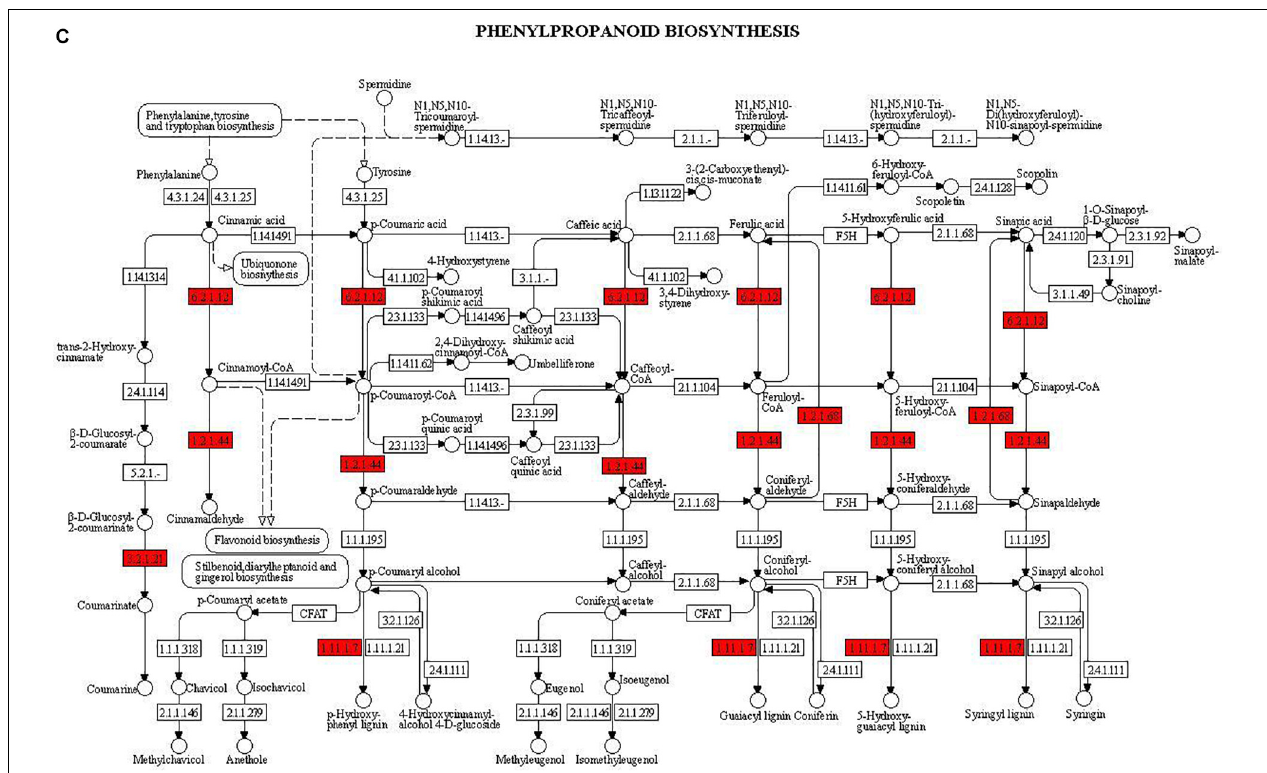
FIGURE 6 | KEGG enrichment for DEGs from the three pathways: (A) carbon fixation, (B) glutathione metabolism, and (C) phenyl propanoid biosynthesis. The red highlights represent the enriched enzymes of the pathways.